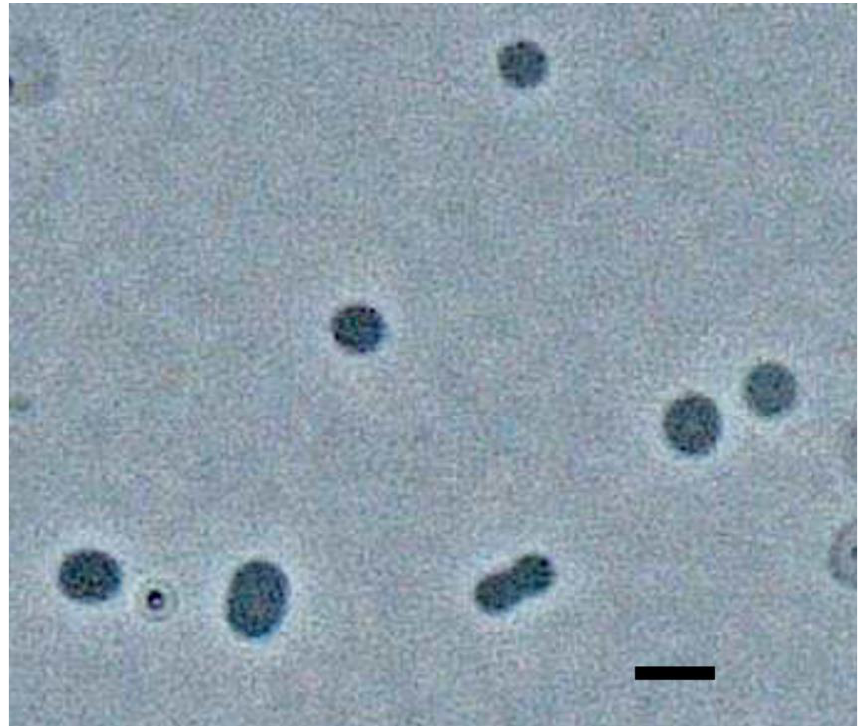
Figure 1. Phase-contrast microscopy image of strain T7324. Scale bar: 2 µm. The photo was taken at the.Leibniz-Institute DSMZ GmbH, Department Microbiology. Table 1. Genome statistics of T. bergensis T7324 T and T. litoralis DSM 5473 T .